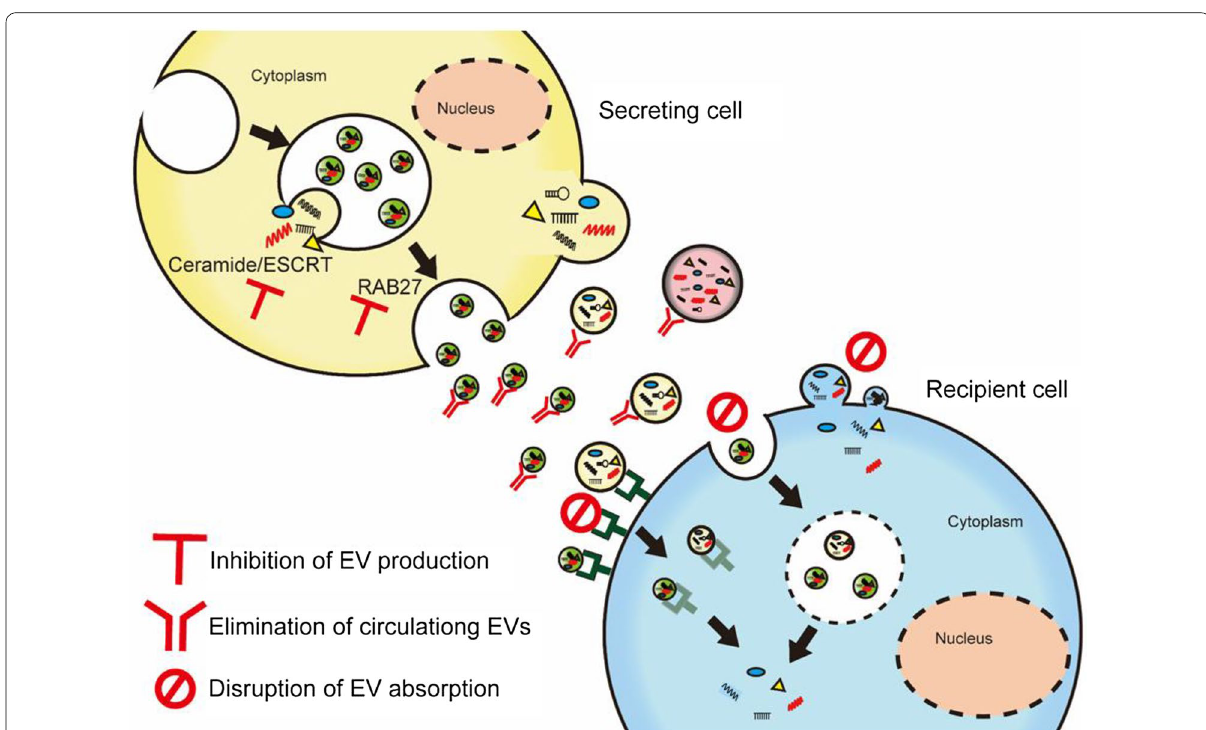
Fig. 3 Schematic of EV-targeting therapy. Intercellular transfer of the EV cargo contributes to cancer development, so reducing EV transfer will pro- vide new therapeutic strategies. Inhibition of EV production, elimination of circulating EVs and disruption of EV absorption will be main